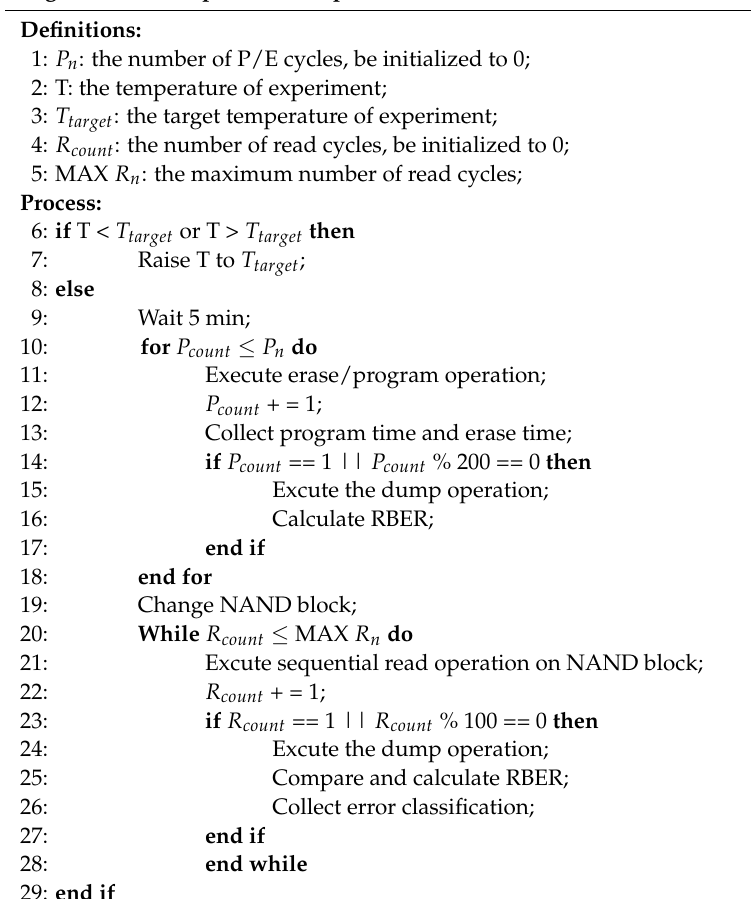
Algorithm 1. The process of